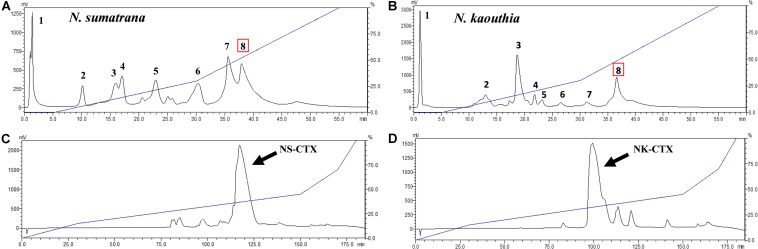
Purification of cytotoxins from Naja sumatrana and Naja kaouthia venoms with sequential high-performance liquid chromatography (HPLC). (A,B) Resource S cation-exchange HPLC of N. sumatrana and N. kaouthia venoms, respectively. (C,D) C18 reverse phase-HPLC of CTX-containing Fraction 8 eluted from cationic-exchange chromatography of N. sumatrana and N. kaouthia venoms, respectively. Arrows indicate the major basic cytotoxins purified.